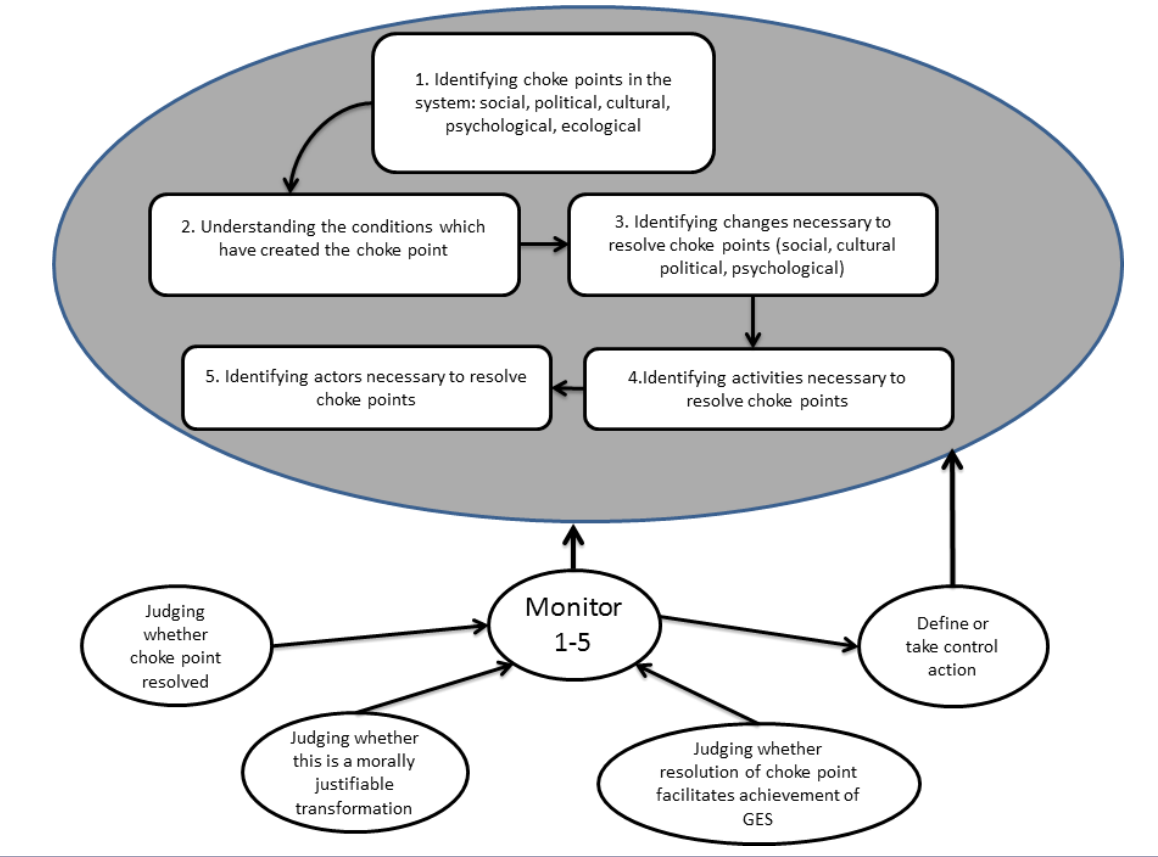
Fig. 3. Soft system model for identifying and acting upon system choke points for achieving Good Environmental Status (GES; based on Checkland and Poulter 2006). The generic monitoring steps of this model are taken directly from examples in Checkland and Poulter (2006).